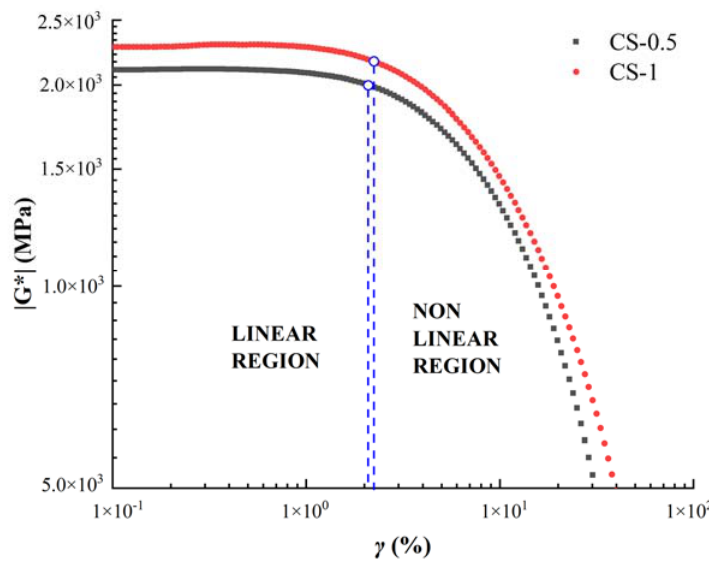
Figure 8. Strain sweep curves (CS ‐ 0.5 and CS ‐ 1 at 25 °C).